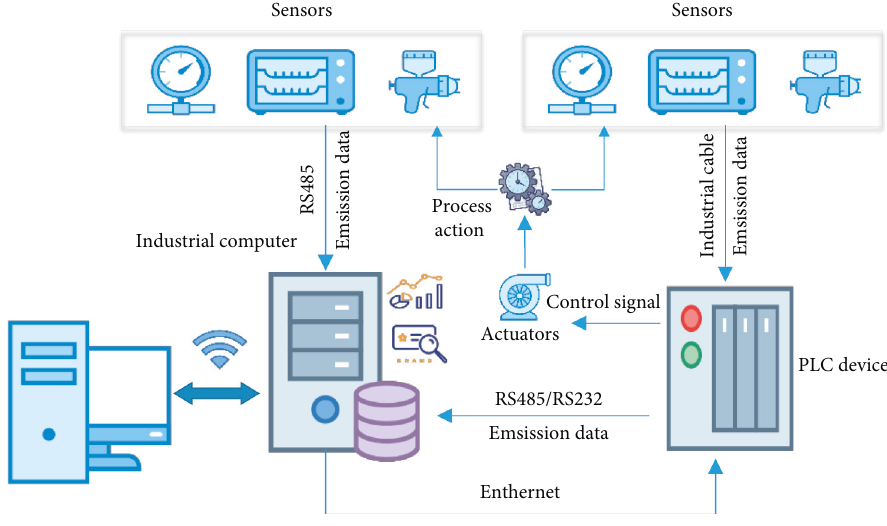
Figure 1: The high-level architecture of a DAPS for CEM.